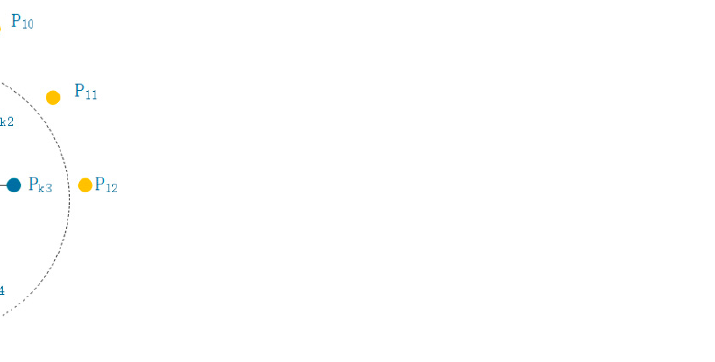
Figure 4. Schematic diagram of FPFH constructing r neighborhood.